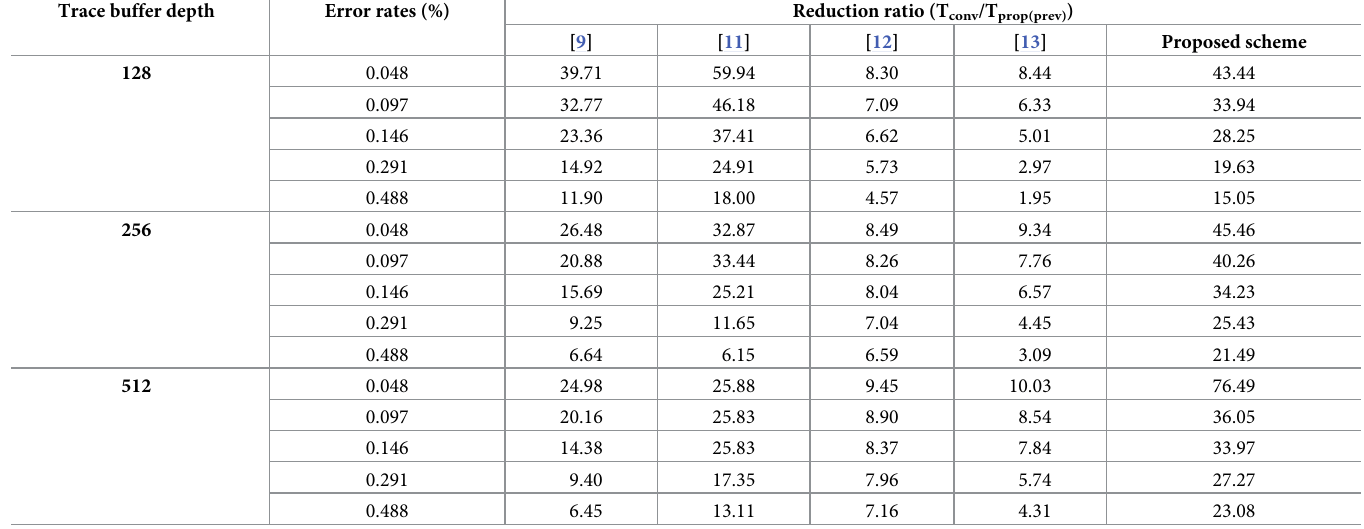
Table 2. Debug time reduction ratio in the same observation window.